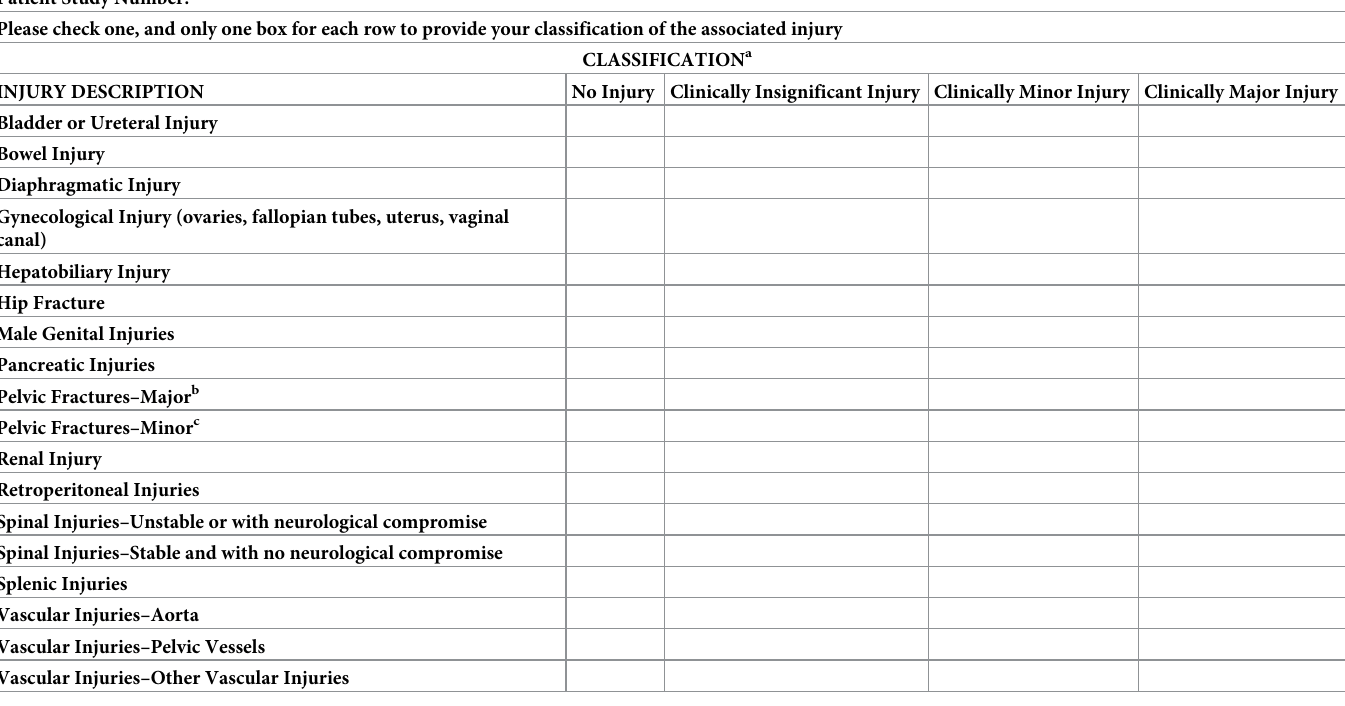
Table 2. NEXUS abdominal/pelvic CT imaging injury assessment form. Patient Study